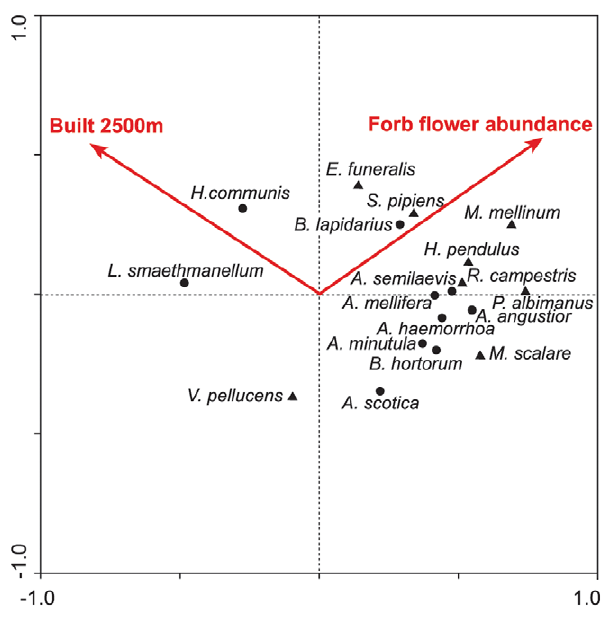
Figure 4. Redundancy analysis (RDA) showing species abun- dance responses to Built 2500m and Forb flower abundance. The position of bee and hoverfly species in the ordination space are shown with filled circles and triangles respectively. For clarity, only species with the best model fit are illustrated.